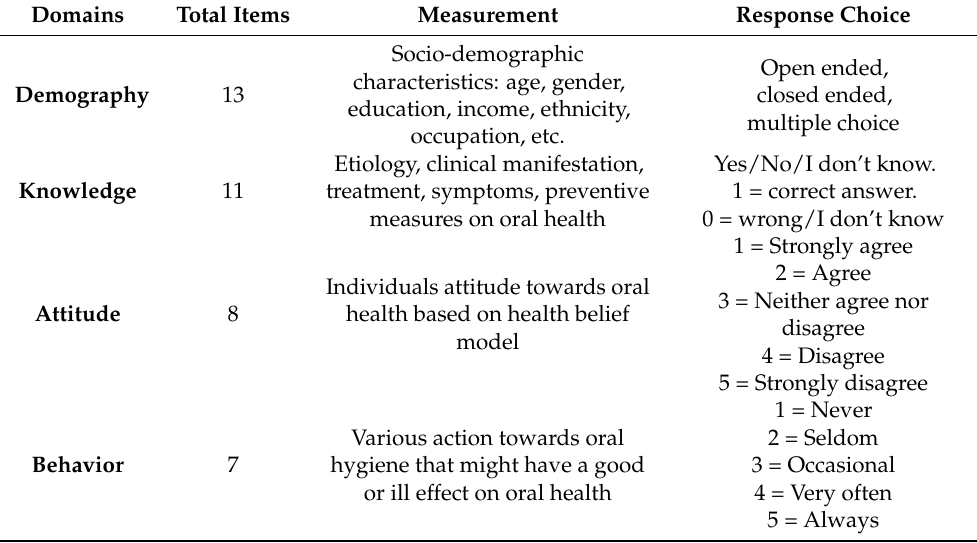
Table 1. KAB Questionnaire towards Oral